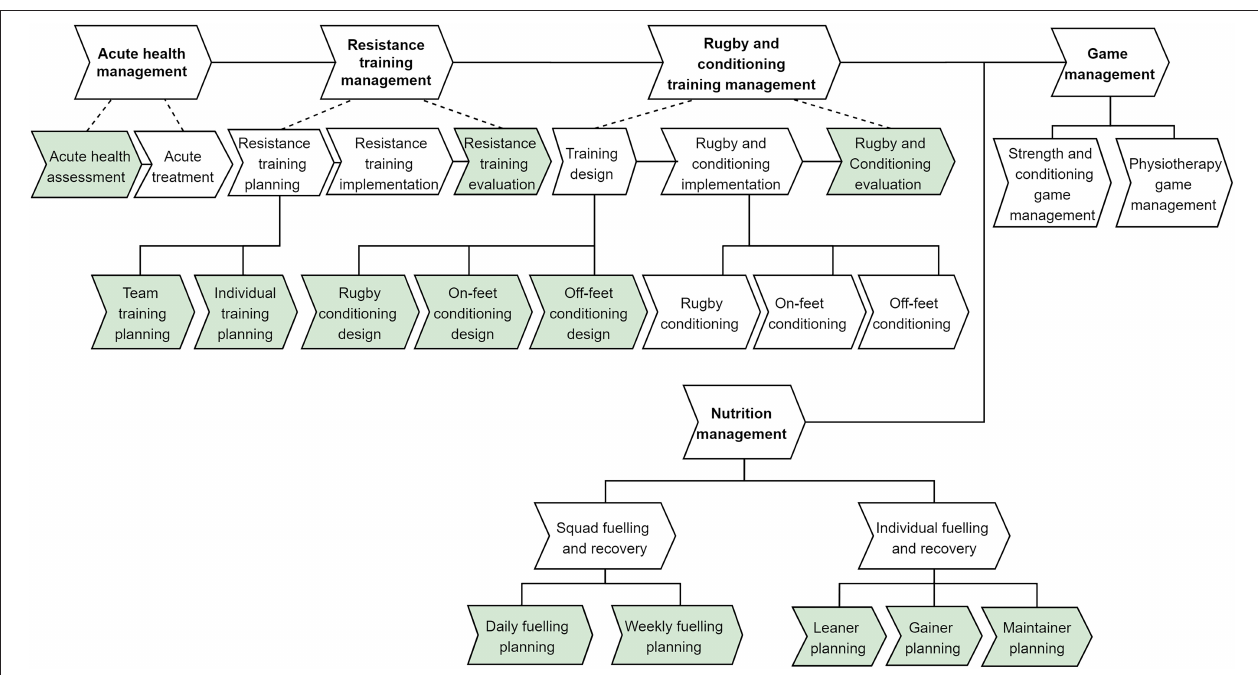
FIGURE 2 | Process relationships in performance management core value chain.